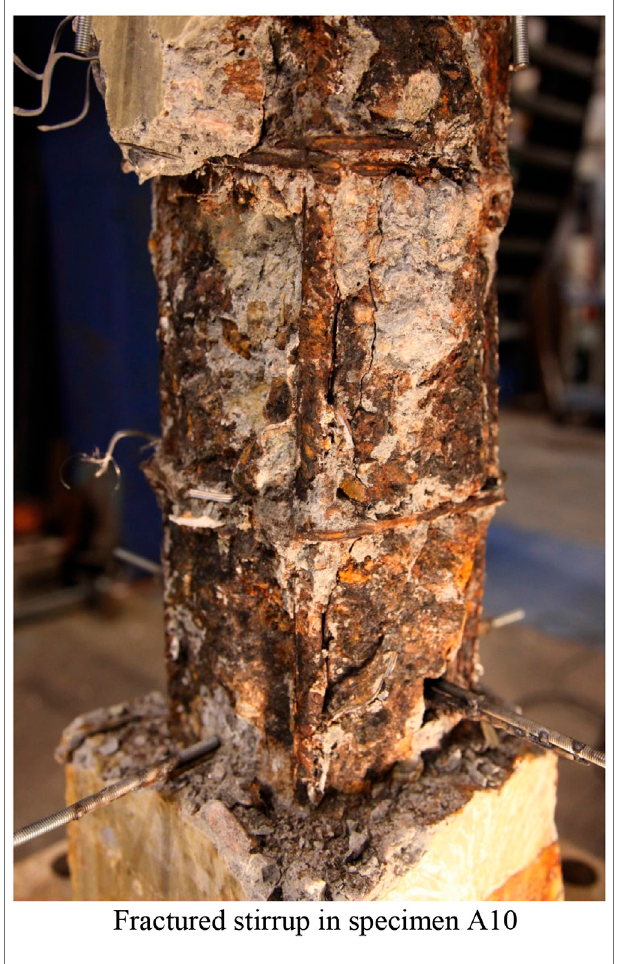
FIGURE 8 | Fractured stirrup in specimen A10.